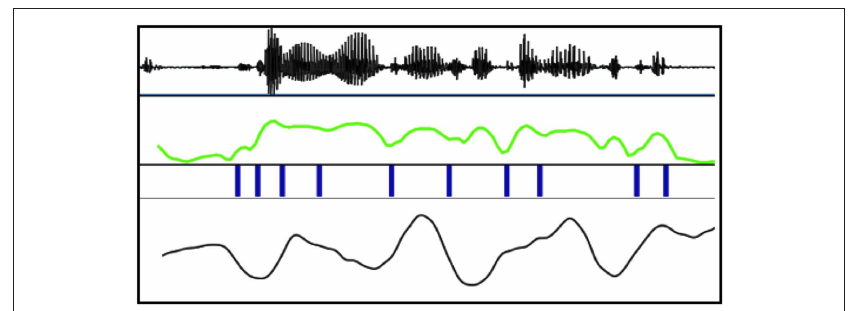
Figure 1 | From top: sound wave, amplitude envelope, approximate syllable boundaries, and first principal component of jaw movement in the mid-saggital plane for one fairly rapid utterance of the Slovak sentence that might be represented canonically thus: / "tSi:.ta.m"i.ba.mu."kra:.sñE."pO.grE:ts.ki /, but in this instance is spoken rather as / "tSI ˚.ta.mI.bmu.kra:.sñE.pO.grEts.ki